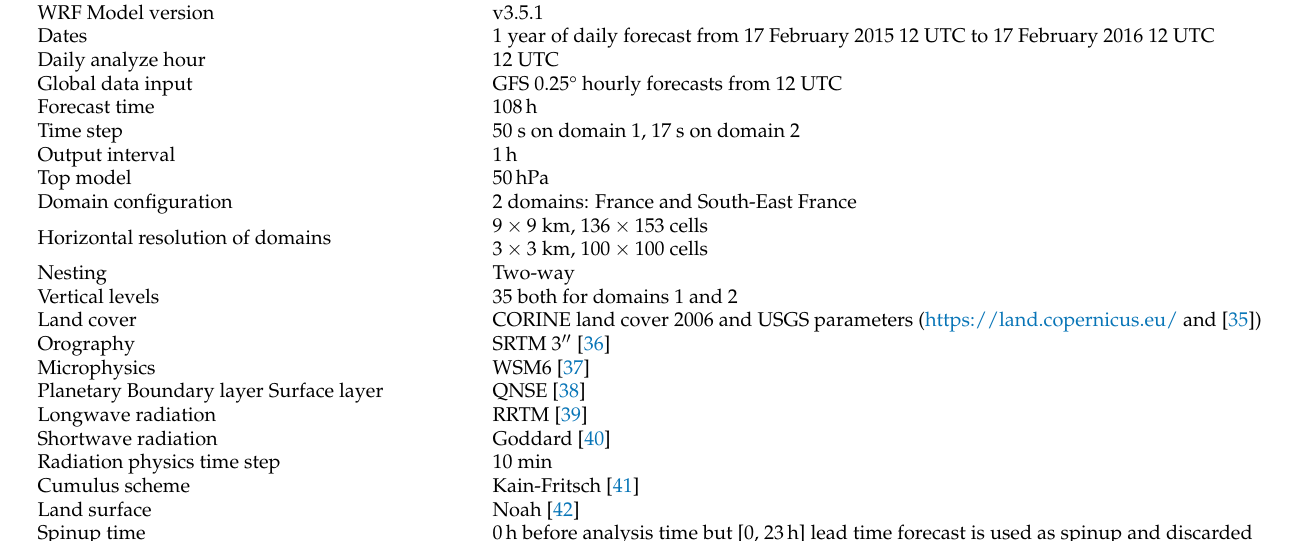
Table 2. Summary of the WRF setup used in the present study.